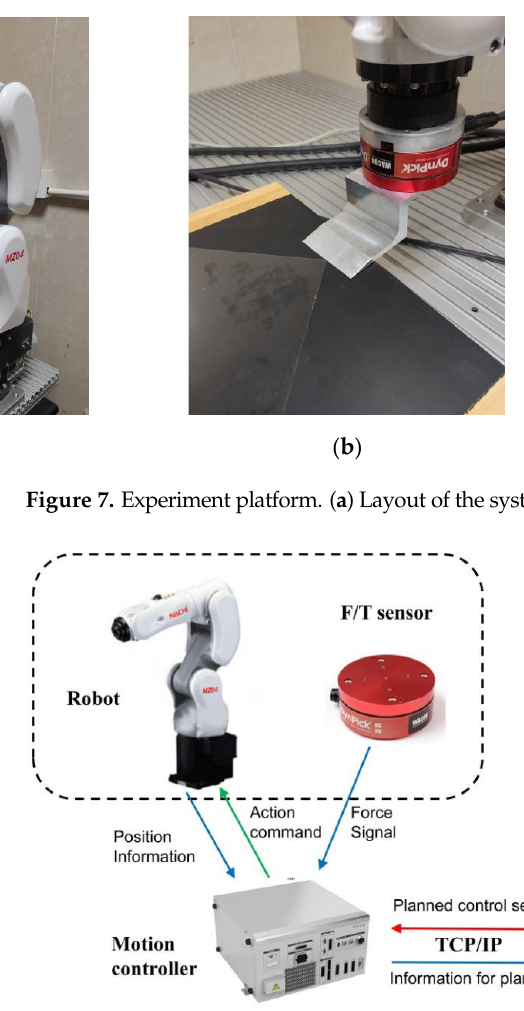
Figure 8. Experiment system layout.